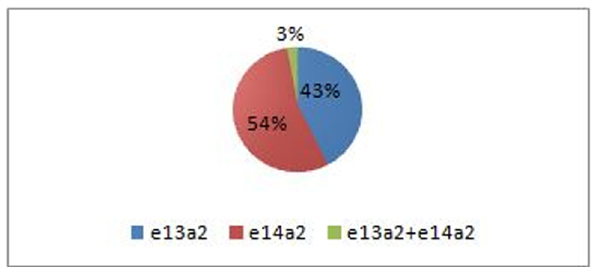
Figure 3: Frequency of di ff erent types of BCR – ABL transcripts among 70 CML patients in chronic phase analyzed in the study. Total of 38 ( 54% ) patients had solitary expression of e14a2 transcript. Expression of e13a2 exclusively was found in 30 ( 43% ) patients. Co - expression of both types of transcripts ( e13a2 + e14a2 ) was observed in only two ( 3% ) patients. The types of transcripts detected in all patients are color coded as shown in